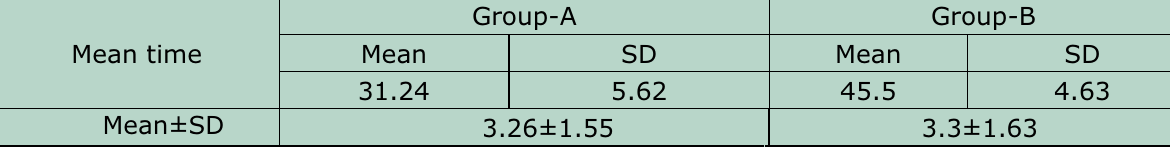
Table-III: Mean time to achieve bp control in both groups